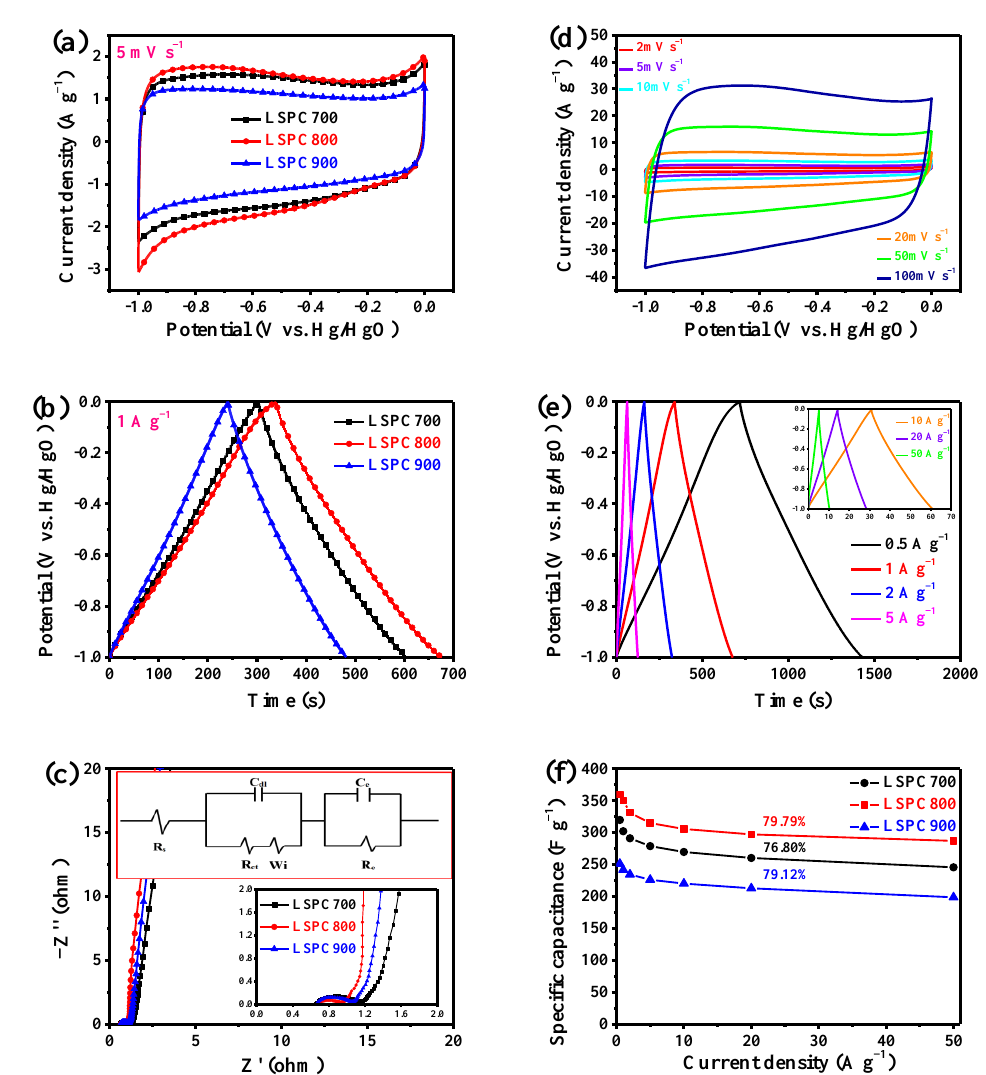
Figure 7. Electrochemical performances of the LSPCs in 6 M KOH using a three-electrode system: ( a ) cyclic voltammetry (CV) curves at 5 mV s − 1 ; ( b ) galvanostatic charge–discharge (GCD) curves at a current density of 1 A g − 1 ; ( c ) the Nyquist plots and the equivalent circuit in the inset; ( d ) CV curves of LSPC800 at scan rates varying from 5 to 100 mV s − 1 ; ( e ) GCD curves of LSPC800 at current densities varying from 0.5 to 50 A g − 1 ; and ( f ) specific capacitance at di ff erent current